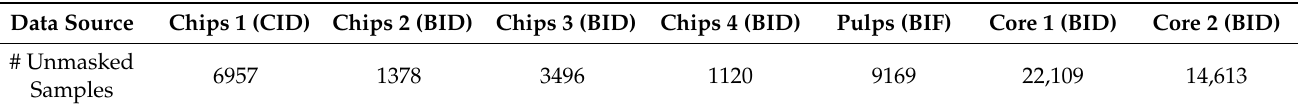
Table 2. The seven spectral data sources used in this study and the total number of spectral samples for each dataset prior to any masking.